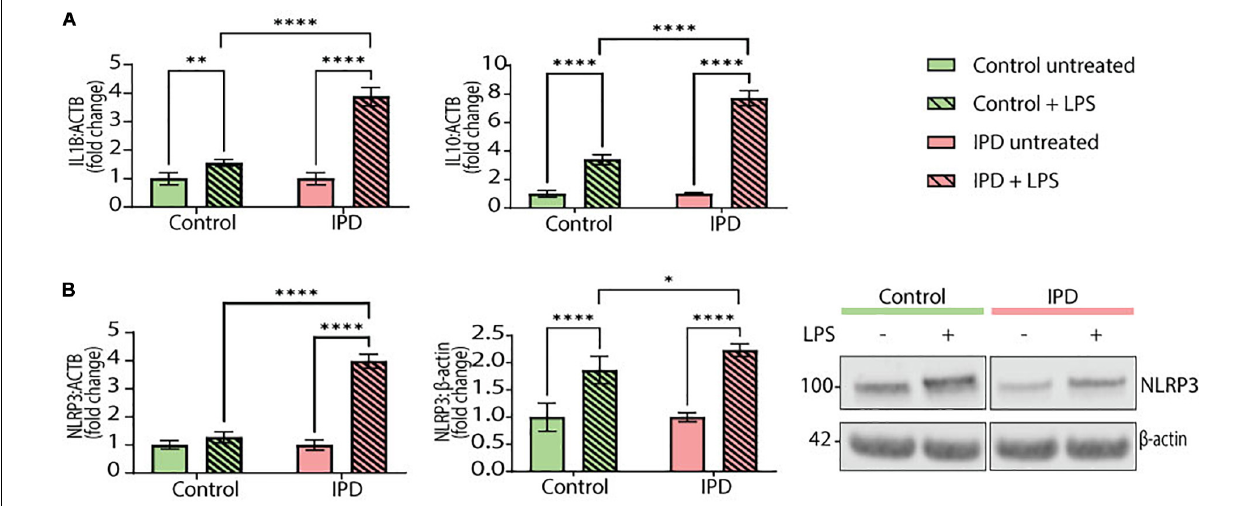
FIGURE 4 | Inflammatory phenotype and LRRK2 levels in iPSC-derived microglia. (A) IL1B and IL10 gene expression (normalized to ACTB ) in control and IPD microglia; a quantitative PCR showed higher gene expressions of IL1B and IL10 in IPD compared to control cells upon priming with LPS (100 ng/ml). Values are represented as fold changes of untreated cells. (B) NLRP3 mRNA and protein levels (normalized to ACTB and β -actin, respectively) are increased in IPD microglia compared to control cells upon priming with LPS (100 ng/ml). Values are represented as fold change of untreated cells. ∗ p < 0.05; ∗∗ p < 0.01; ∗∗∗∗ p < 0.0001; IPD, idiopathic PD, NLRP3, NOD-, LRR-, and pyrin domain-containing protein